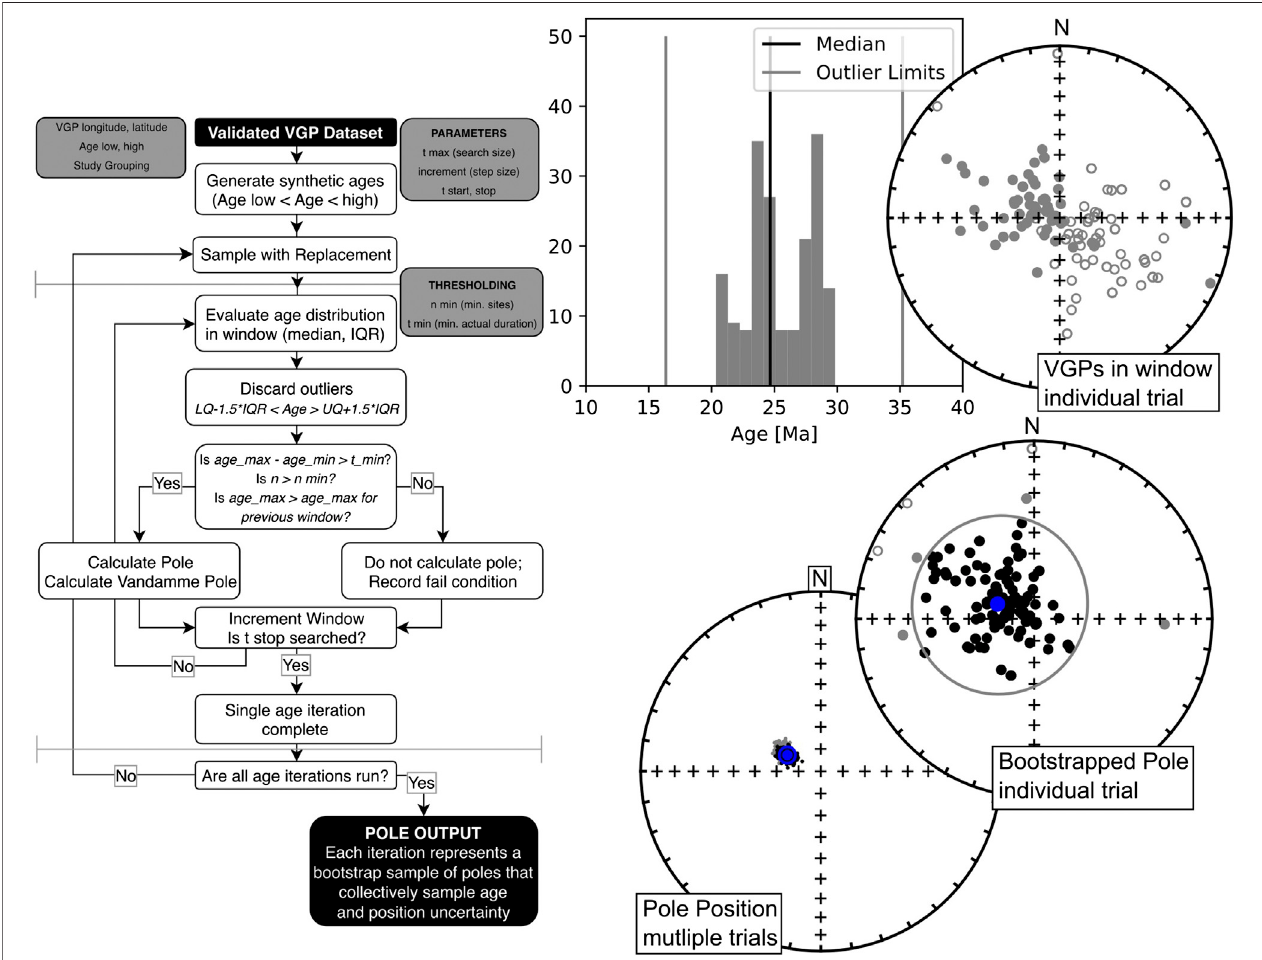
FIGURE 4 | Control fl ow diagram ( left ) describing method used to generate bootstrapped poles and an accompanying example ( right ) for the 20 – 30 Ma search window. t start and t stop represent the age range desired for the entire search (the Cenozoic in this case), t max being the window size. Thresholding rules n min (minimum number of sites) and t min (minimum age range for VGPs in a given interval) can be speci fi ed. Thresholding can, of course, be applied to pole results after the fact (by setting n min and t min to zero), but results in longer runtime for reasons described in text. Age distributions within each interval are evaluated fi rst, and thresholding rules applied (in the example histogram these fall beyond the search domain as VGPs are well represented over the interval). A bootstrap paleomagnetic pole is calculated, both including and excluding transitional sites (the example showing the variable VGP cutoff-angle in gray) (Vandamme, 1994). The window is then incremented, and the process repeated for multiple trials until the search is complete, leading to a collection of bootrapped poles from which the pole position and uncertainty can be estimated.